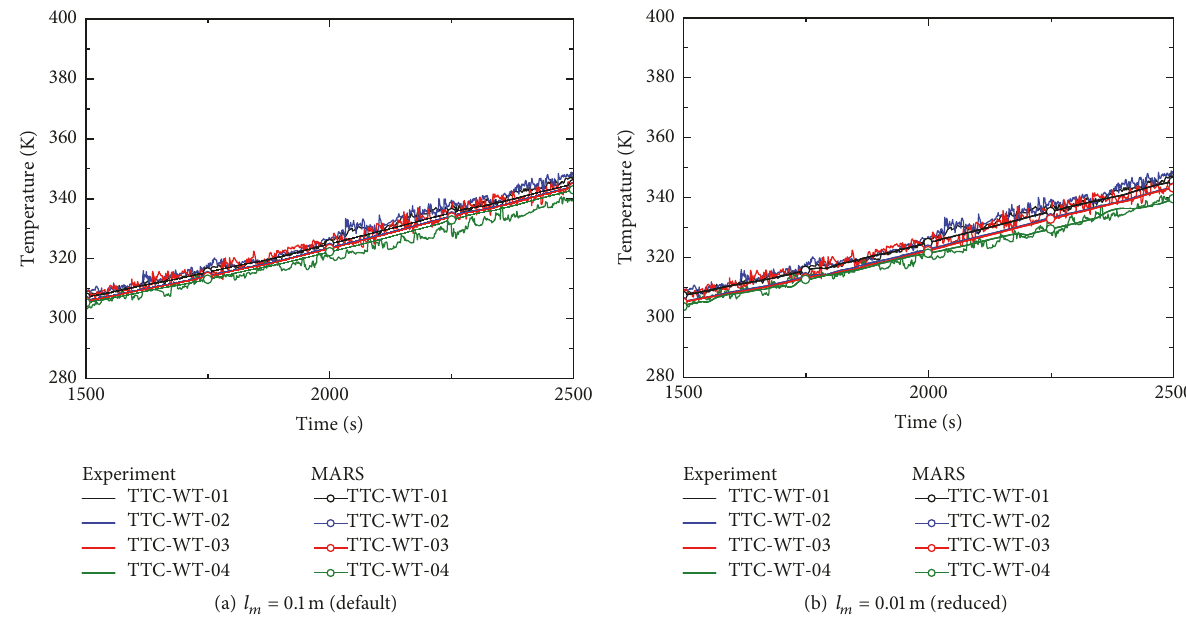
Figure 9: Temperature in the water tank with a change of the mixing